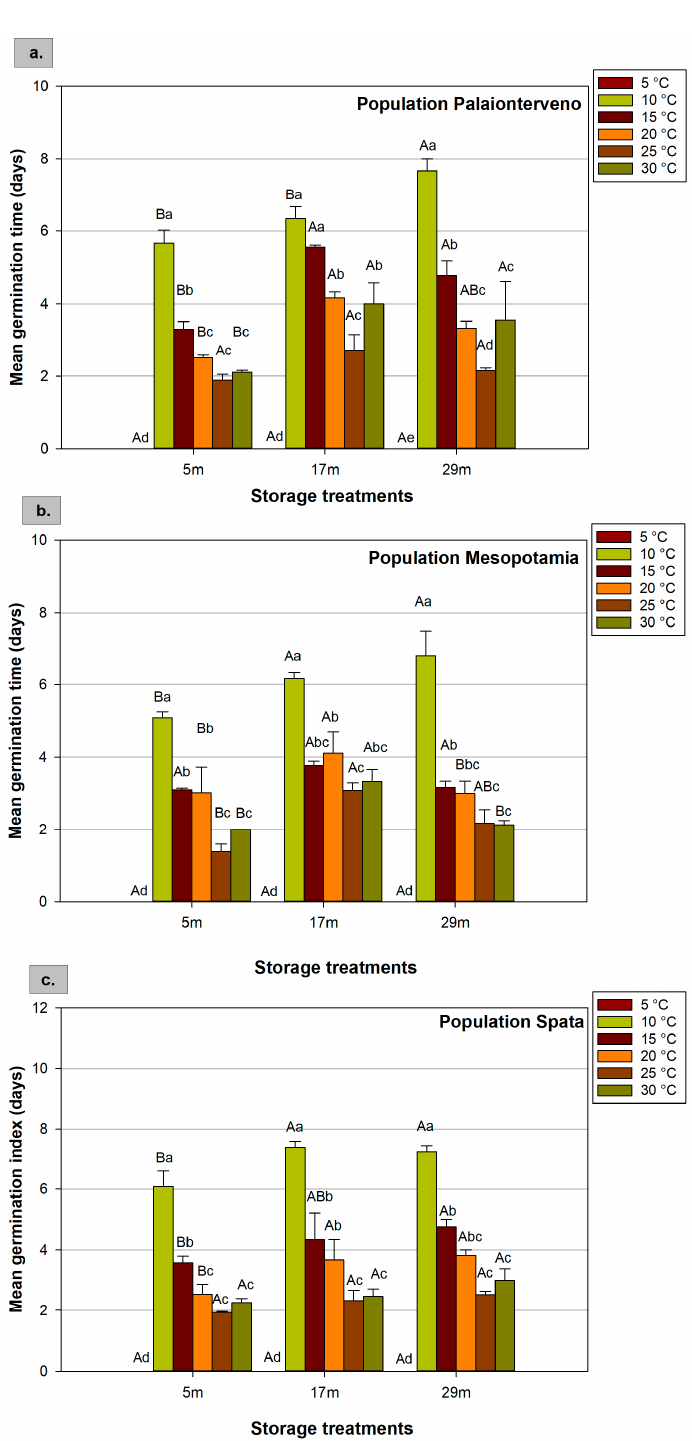
the storage duration and conditions cannot be considered significant (Table 4).